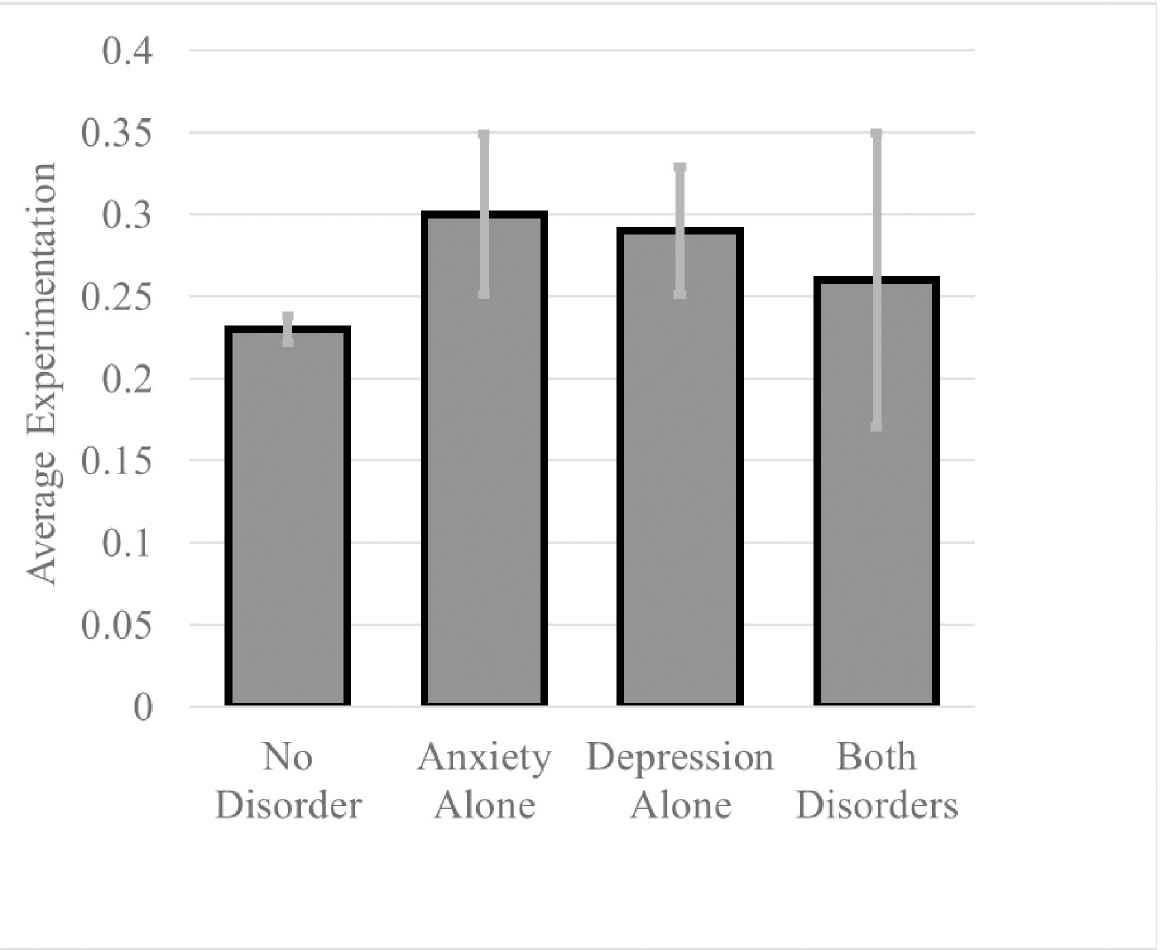
Fig 1. Mean substance experimentation as a function of diagnosis status. Note : Error bars represent 95% Confidence Intervals at alpha = .05.